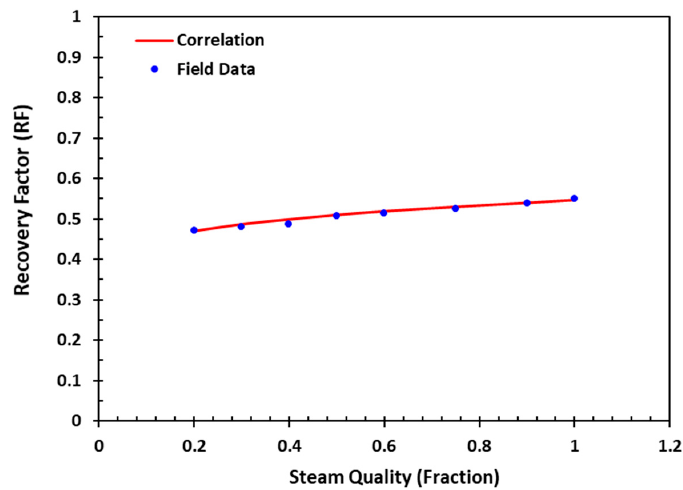
Figure 15. RF vs. steam quality for the database analyzed.